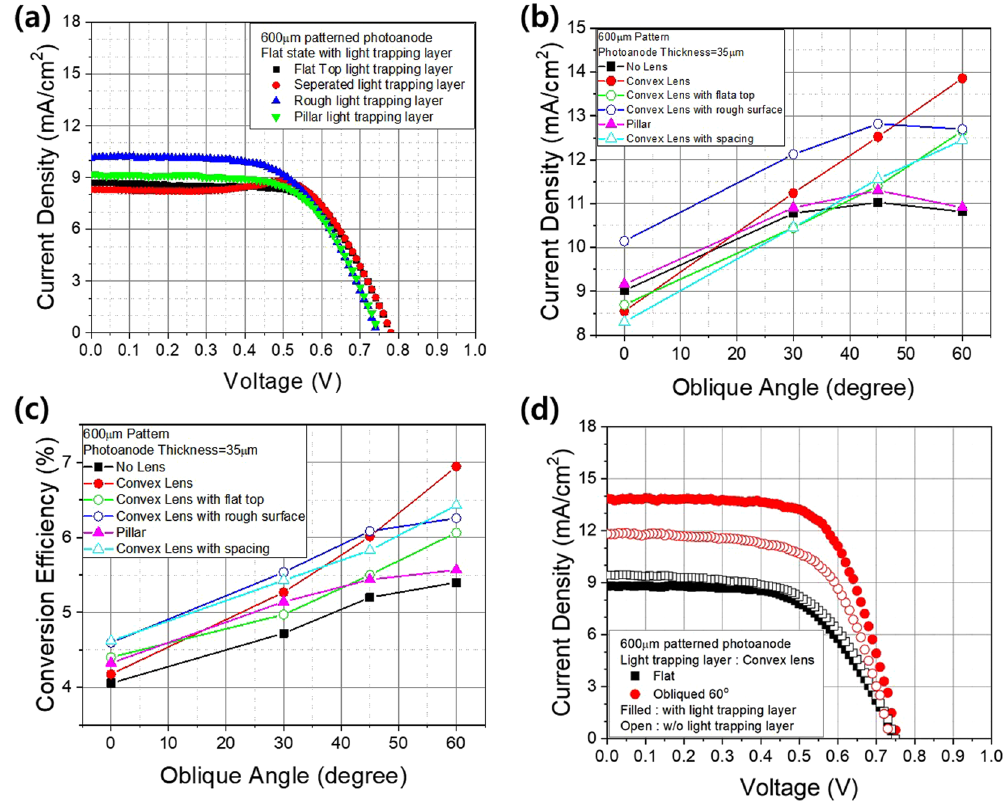
and ( c ) dependence in ( a ) with vertically, 30°, 45°, and 60° obliquely angled incident light under 1 sun AM1.5 conditions. ( d ) Dependence with and without a light-trapping layer with vertically and 60° obliquely angled incident light under 1 sun AM1.5